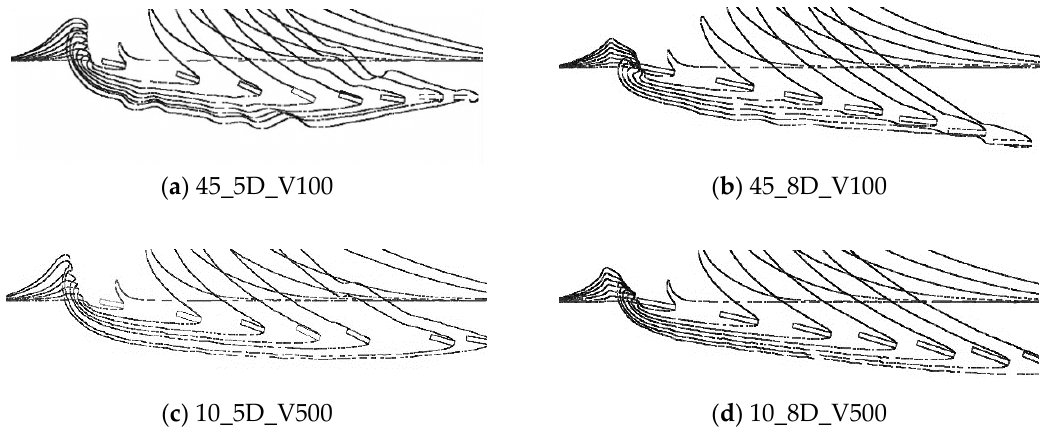
Figure 4. Evolution of water entry at initial angle 10 ◦ : ( a ) 10_5D_V100, ( b ) 10_8D_V100, ( c ) 10_5D_V500, ( d ) 10_8D_V500.